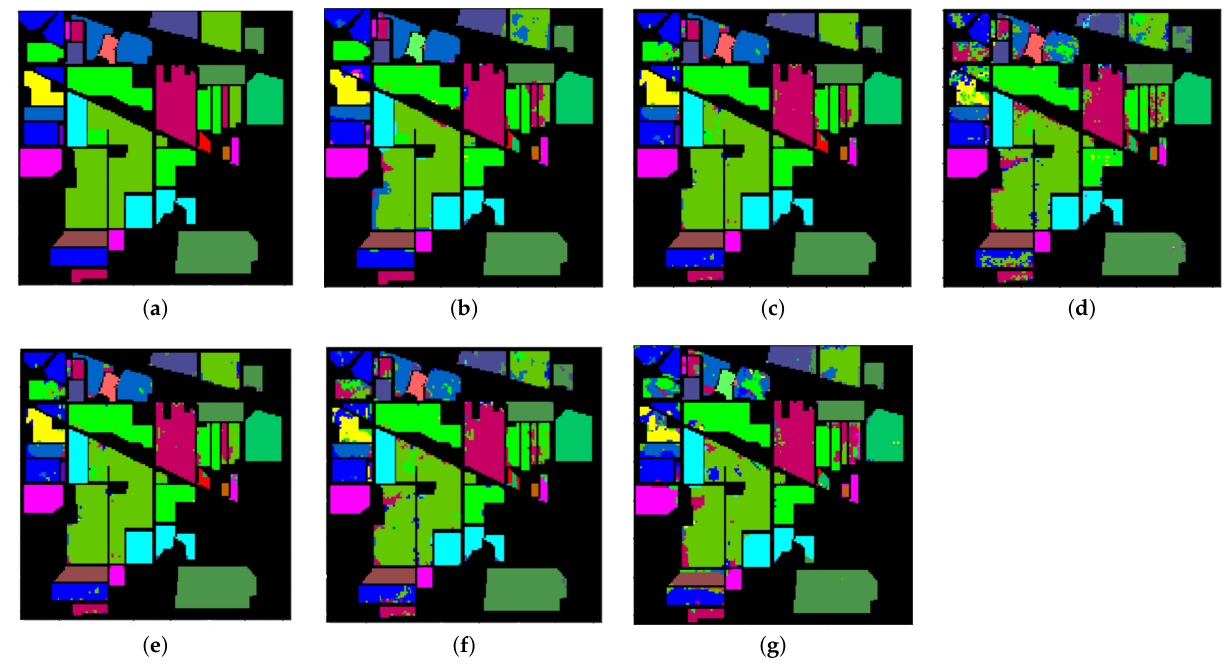
Figure 6. Classification maps of Indian Pines dataset for the proposed dual-branch spatial-spectral attention-based classification framework and methodologies used for comparison using 5% train- ing data. ( a ) Ground Truth; ( b ) SPAT-SPEC-HYP-ATTN (96.21%); ( c ) SPAT-HYP-ATTN (94.06%); ( d ) SPEC-HYP-ATTN (83.86%); ( e ) GAB-RP-S-3DCNN (91.57%); ( f ) SSAN (88.71%); ( g ) SVM-CK (87.93%).